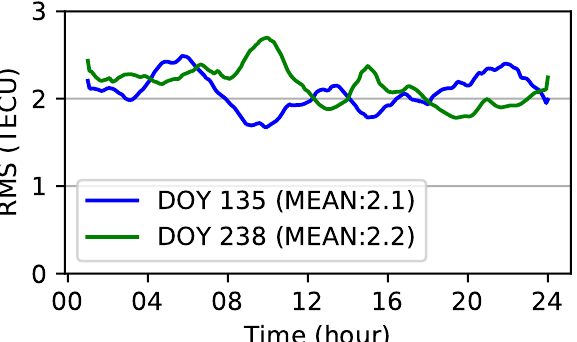
Figure 10. RMSE values of modeling residuals on DOY 135 and DOY 238, 2018.